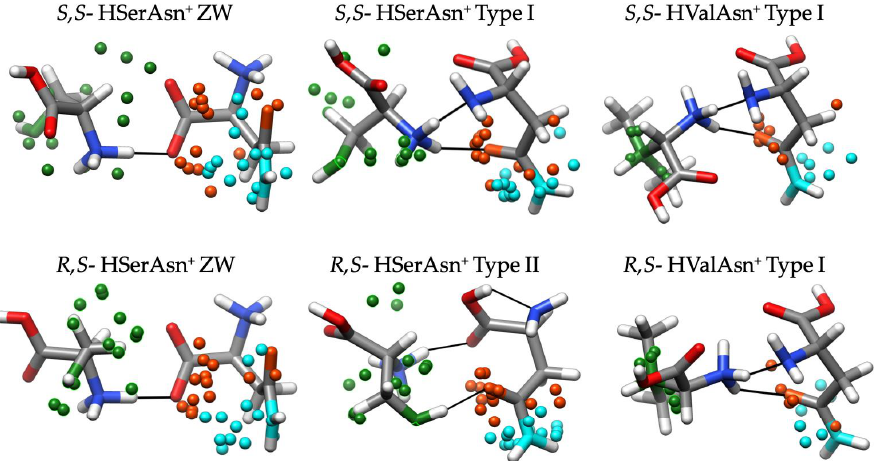
Figure 2. Global minimum structures of the Type ZW, Type I and Type II binary species. See Section 2.2 for the definition of different types. The O and N atoms in the Asn sidechain are coloured in orange and turquoise, respectively, and the O and tertiary C atoms in the Ser and Val sidechains are coloured in green. The additional points indicate the positions of the highlighted sidechain atoms among all other final structures.